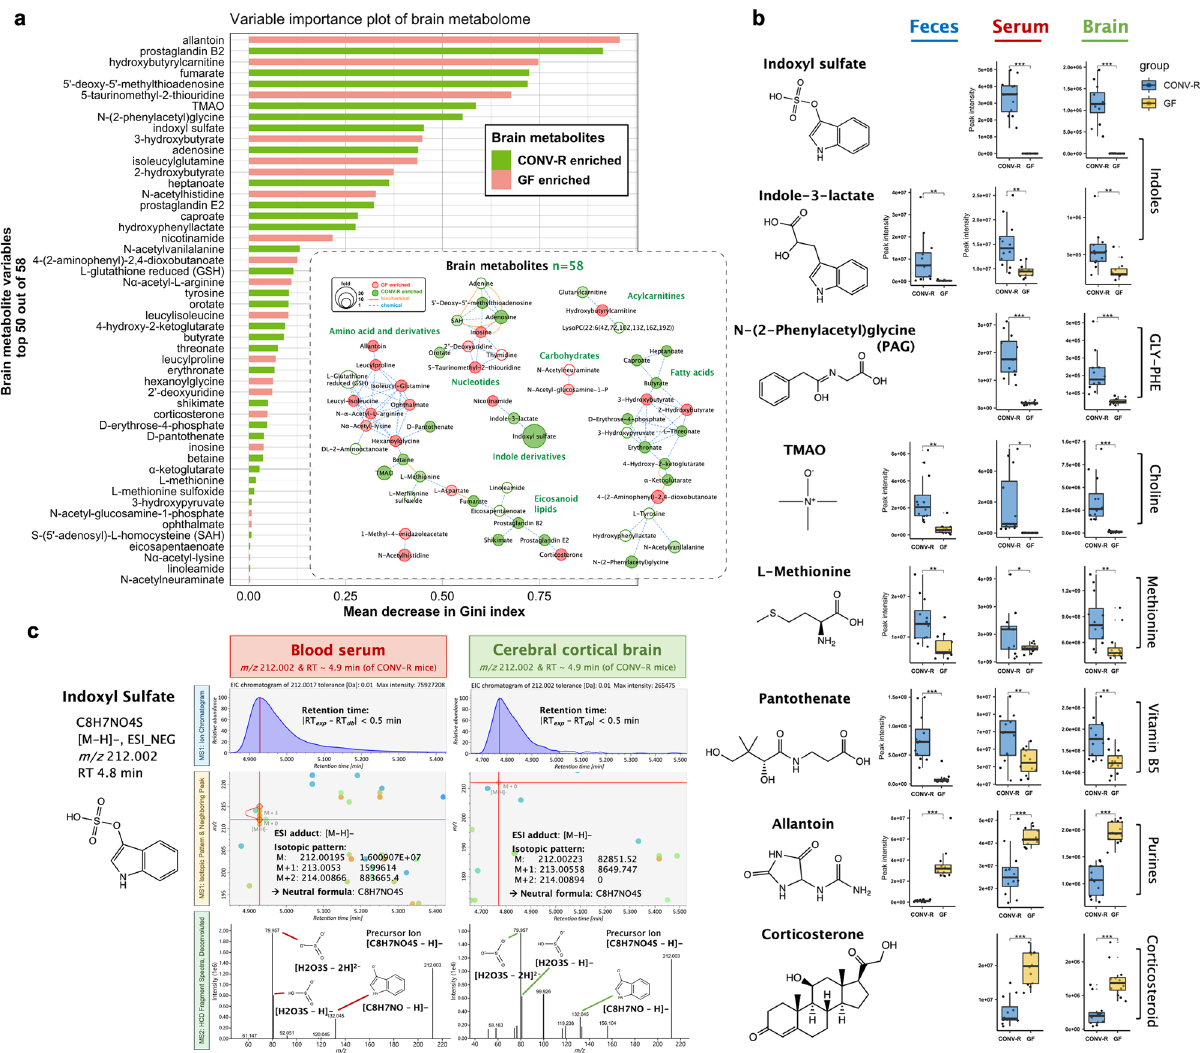
Fig. 7 Metabolites of microbial neuroactive potential: integrated analyses of cerebral cortical brain, fecal and blood serum metabolomes. a Variable importance plot of top 50 brain metabolites ( y -axis) ranked by contribution to mean decrease accuracy of Gini coef fi cient ( x -axis) in the random forest model for discerning group difference; embedded was a MetaMapp network view of all 58 metabolites altered in cerebral cortical brain tissues owing to microbiota, with nodes representing individual metabolites, edges for biochemical (Kyoto Encyclopedia of Genes and Genomes, i.e., KEGG reactant pairs) and chemical (Tanimoto coef fi cient > 0.7) relationships and lower transparency for lower p values (<0.05, two-sided Welch ’ s t test). b Box and Whisker plots of select metabolites exhibiting systemic alterations across feces, blood sera, and cerebral cortical brain tissues as mediated by microbiota, with the box ranging from the fi rst quartile to the third while the whiskers going from each quartile to the minimum or maximum ( n = 24), * p < 0.05, ** p < 0.01, *** < 0.001, **** p < 0.0001, two-sided Welch ’ s t test; exact p values and adjusted p values (i.e., q values) are provided in Supplementary Data 4. ( c ) Structural annotation of ion feature m/z 212.002 at the retention time of 4.9 min as indoxyl sulfate that was highly enriched in CONV-R blood sera (4351.6-fold) and cerebral cortical brain tissues (26.8-fold) compared with GF mice. PAG N-(2-phenylacetyl)glycine, TMAO trimethylamine N-oxide, Gly- Phe glycine-phenylalanine dipeptide, HCD higher-energy C-trap dissociation, EIC extracted ion chromatogram, m/z mass-to-charge ratios, RT exp experimental retention time (from data), RT db reference retention time (from chemical